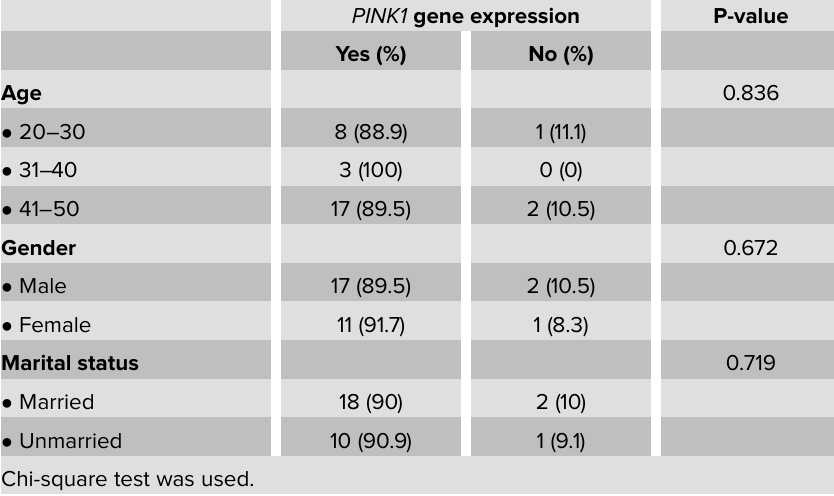
Table 5: Shows the association between PINK1 gene expression and demographic data of the study group.